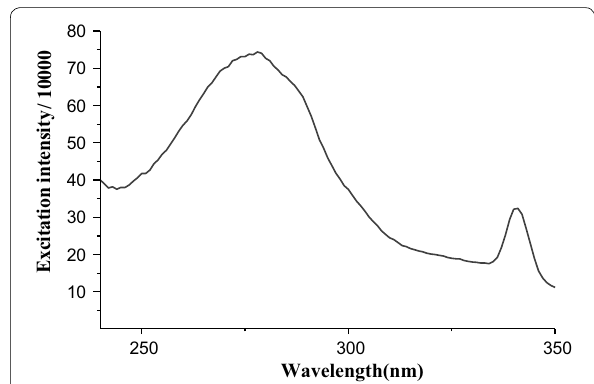
Fig. 8 Fluorescence excitation spectrum of coffee dissolved in